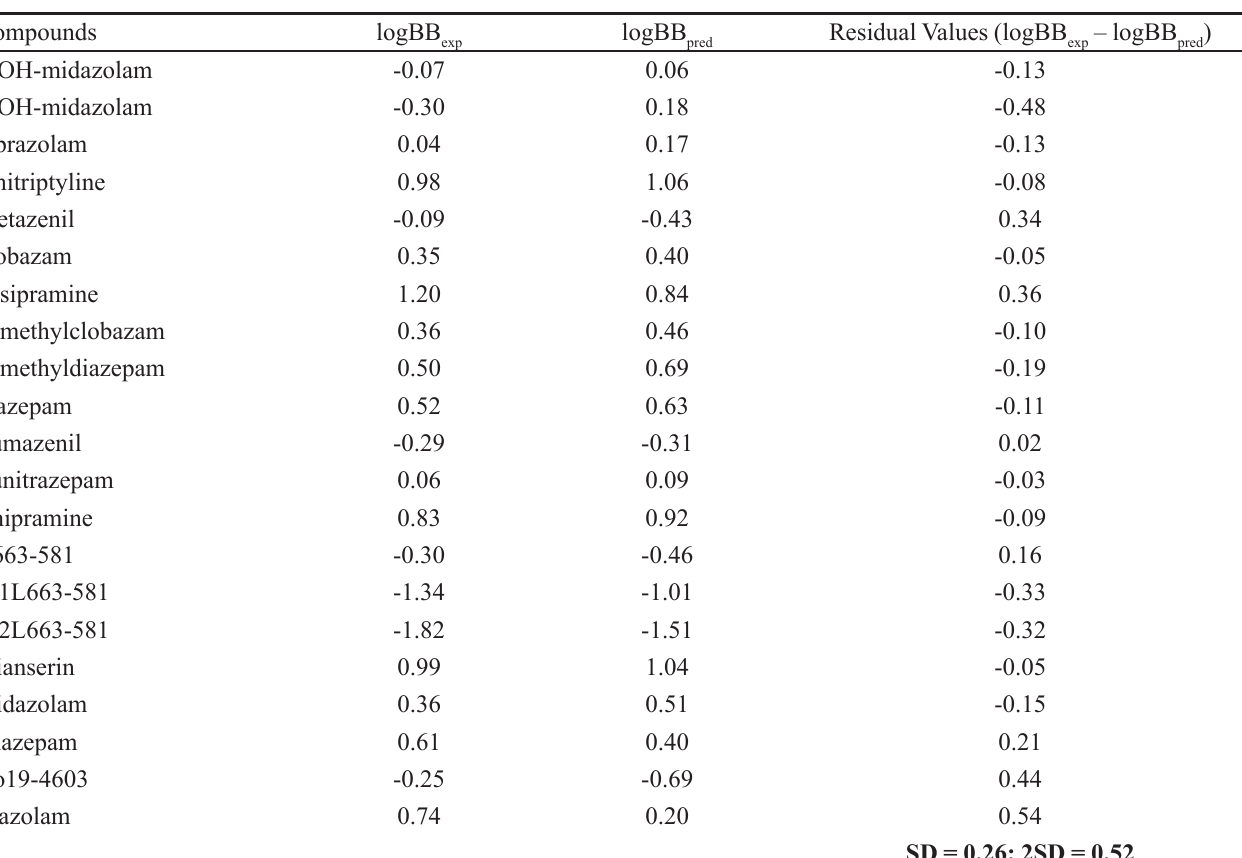
TABLE IV - Residual values found for model 4